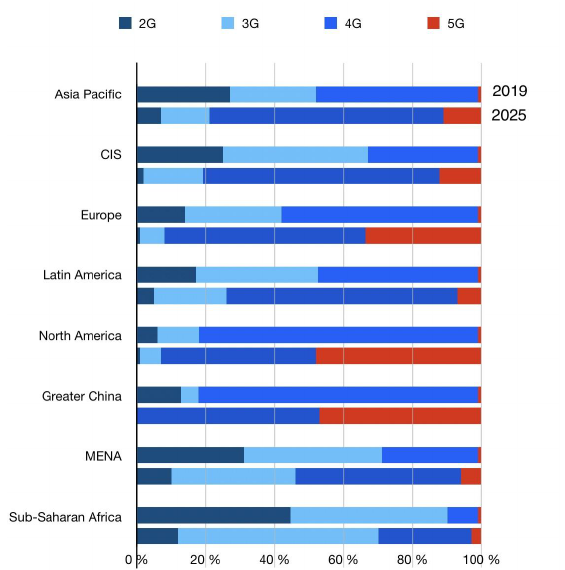
Figure 12. A region-wise prediction of the Change is Network distribution *CIS is Commonwealth of Independent States and MENA is Middle East and North